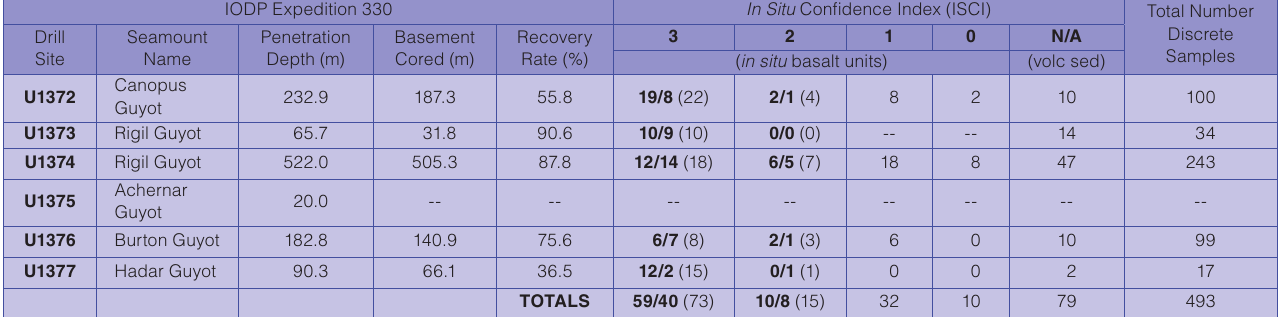
Table 1. IODP Exp. 330 drilling statistics and paleomagnetic sampling of basalts. IODP Expedition